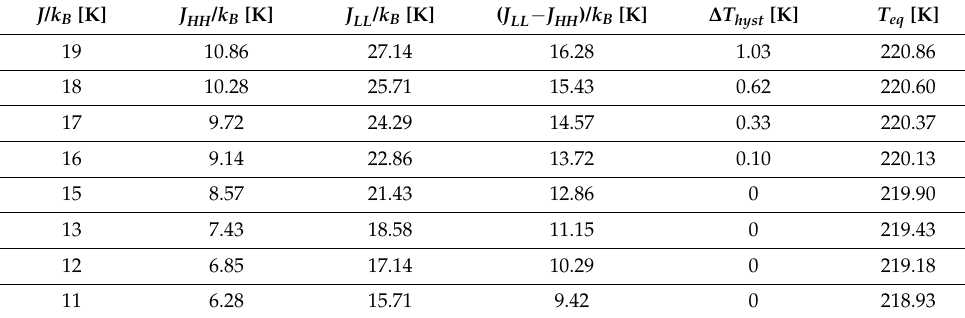
Table 1. Values of the thermal hysteresis width ∆ T hyst = T up − T down and the equilibrium temperature T eq as a function of J / k B , J HH / k B and J LL / k B in a SCO system with a size of 6 × 6. The computational parameters are: ∆ / k B = 1300 K, G / k B = 172.2 K, x = J HH / J LL = 0.4 and ln( g ) = 6.01.